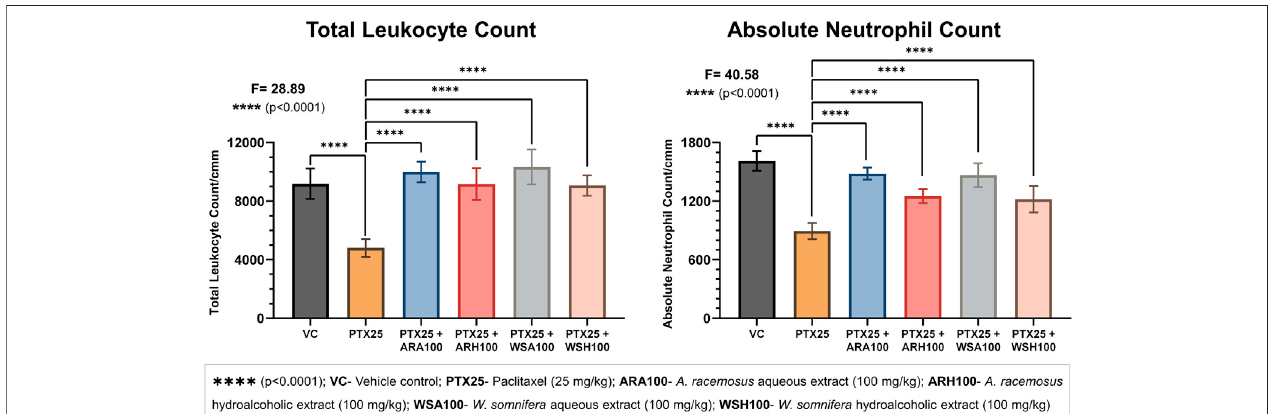
FIGURE2 | Blood cell count analysis. The fi gure depicts thatARA, ARH, WSA, and WSH signi fi cantly prevented PTX-induced leukopenia and neutropenia.PTX at 25 mg/kg dose signi fi cantly ( p < 0.0001) reduces the total leukocyte and neutrophil count. Pre-administration of botanical extracts ARA, ARH, WSA, and WSH at 100 mg/kgdose15 dayspriortoPTXdosingsigni fi cantly( p < 0.0001)preventsthereduction intotalleukocyteand neutrophilcount.Allbotanicalextractsnormalizethe total leukocyte and neutrophil count comparable to VC group. The data points are represented as mean ± SD with n =